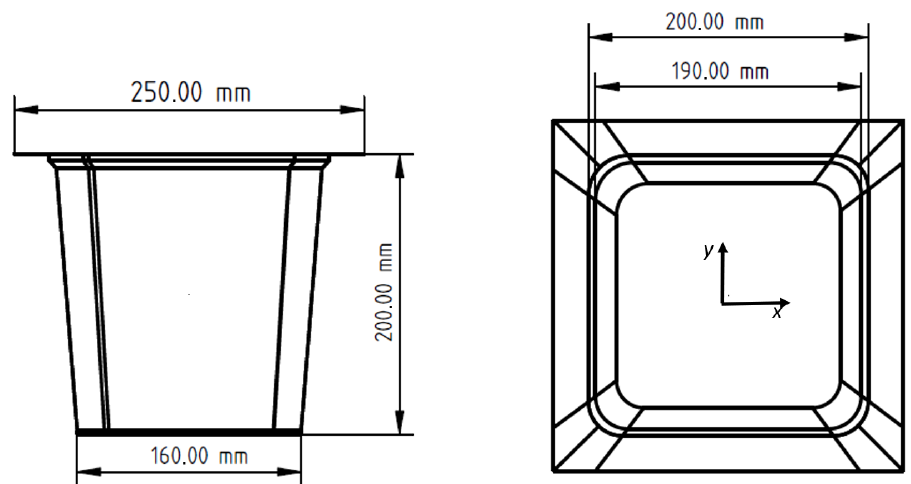
Figure 9. Part dimensions: square cup with rounded vertices.